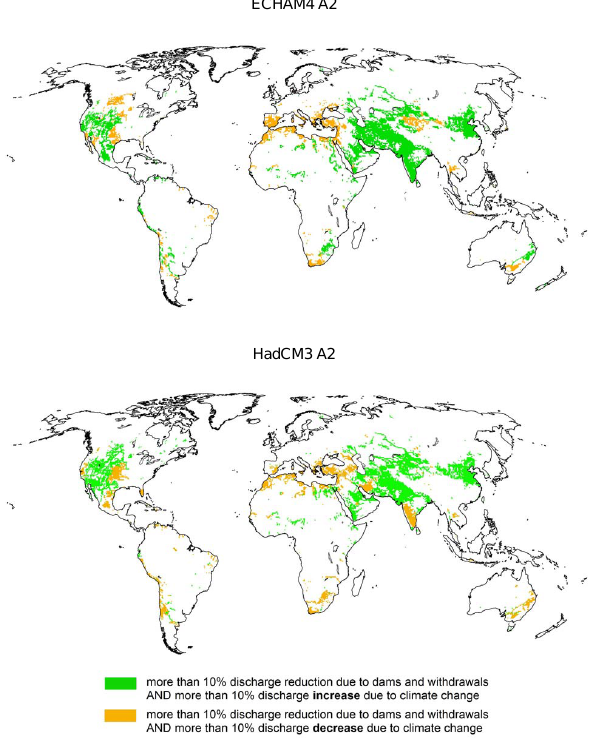
Fig. 8. Areas with significantly reduced long-term average annual discharges due to dams and withdrawals, where discharge increase due to climate change until 2055 may either provide opportunities for ecologically advantageous management of river flows (in green) or where anthropogenic discharge reductions may be significantly exacerbated by climate change (in yellow). Withdrawals and dams in the year 2002, climate change between 1961–1990 and 2041– 2070 according to the emissions scenario A2 as implemented by the global climate models ECHAM4 and